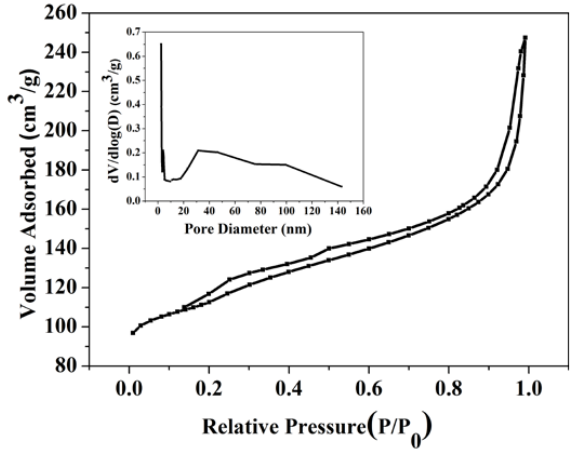
Figure 5. Nitrogen adsorption-desorption isotherms and BJH pore size distribution (inset) of the 0.3% Ga 2 O 3 /ZSM-5 zeolite hollow fibers.